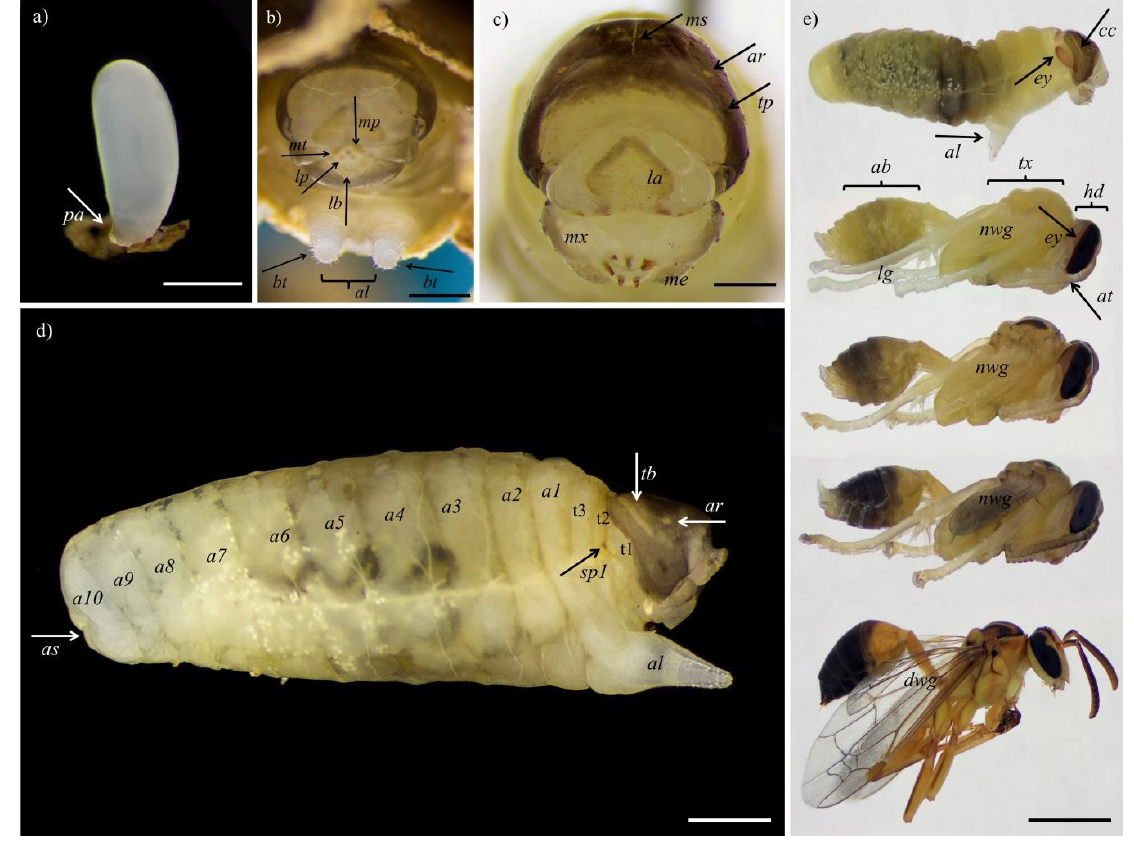
Figure 1: a) Example of one M. cerberus egg attached to a piece of nest material – white bar represents 0.5 mm; b) Frontal view of one fifth- instar larvae with its abdominal lobes in evidence – black bar corresponds to 1.0 mm; c) Frontal view of one fifth-instar larvae cephalic capsule – black bar represents 0.5 mm; d) Lateral view of one fifth-instar larvae – white bar represents 0.5 mm; e) Lateral view from pre-pupae with elongated body of fifth-instar larvae to a fully developed pupae before its emergence – black bar correspond to 5.0 mm. a1 to a10 – abdominal segments from 1 to 10; ab – abdomen; al – abdominal lobes; ar – antennal ring; as – abdominal slot; at – antenna; bt – bristles; cc – cephalic capsule; dwg – developed wings; ey – compound eyes; hd – head; la – labrum; lb – labium; lg – legs; lp – labial papilla; me – mentum; mp – maxillary papilla; ms – median suture; mt – mandible tooth; mx – maxilla; nwg – non-developed wings; pa – point of attachment; sp1 - spiracule 1; t1 to t3 – thoracic segments from 1 to 3; tb – temporal band; tp – tentorial pit; tx –